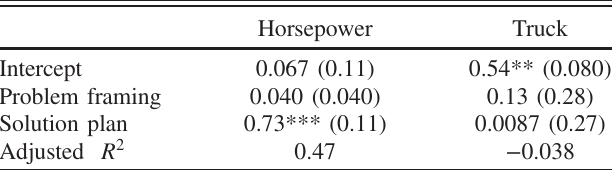
TABLE II. Multiple regression analysis of execution score on framing score and planning score for the three exam problems. Coefficients represent the fractional change in execution score per one-point change in planning or framing score. *** p < 0 . 001 , ** p < 0 . 01 , * p < 0 . 05